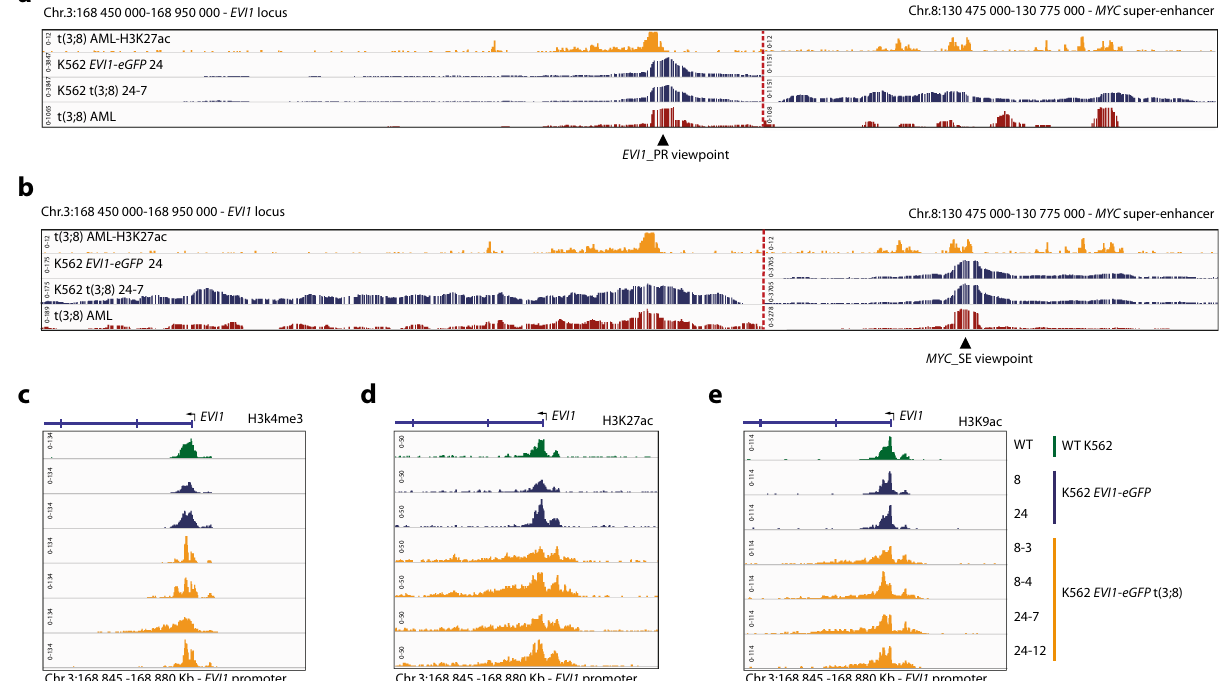
Fig. 3 EVI1 promoter hyperactivation upon interaction with MYC SE in t(3;8) AML. a Chromatin interaction shown by 4C-seq data, using the EVI1 promoter as the viewpoint (triangle symbol). The upper panel shows H3K27ac ChIP-seq data of a t(3;8) primary AML (AML-17). Indicated by H3K27ac signal peaks, on the left is the EVI1 promoter and on the right is the − 1.7 Mb MYC super-enhancer, separated by a dotted red line. In the fi rst 4C track (blue), parental K562 EVI1-eGFP clone 24; in the second, K562 t(3;8) EVI1-eGFP clone 24-7 (also blue); and in the bottom track (red), data of a primary t(3;8) AML (AML-17). b Similar to a , but using the MYC super-enhancer as the viewpoint (triangle symbol). The long stretch (500 Kb) of chromosomal interaction shown for the K562 t(3;8) EVI1-eGFP clone 24-7 shows a high resemblance with the interaction seen for the primary t(3;8) AML (AML-17) (second blue and red tracks, respectively). c H3K4me3 ChIP-seq data for K562 EVI1-eGFP parental lines (blue), the t(3;8) clones 8-3, 8-4, 24-7, 24-12 (orange), and K562 WT (green). A peak located on the EVI1 transcriptional start site marks the promoter region. d H3K27ac ChIP-seq data, comparing EVI1 promoter activation of the four t(3;8) clones (orange) to the EVI1-eGFP parental lines (blue) or K562 WT (green). e H3K9ac ChIP-seq data, con fi rming the hyperactivation of the EVI1 promoter in the t(3;8) clones (orange), compared to the parental lines (blue) or K562 WT